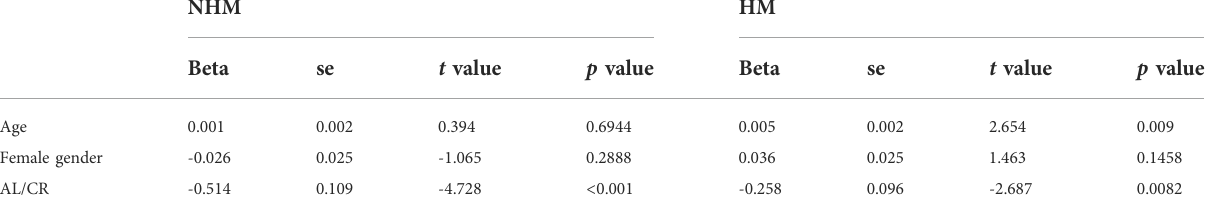
TABLE 2 Modeling of the potential association of SSI with AL/CR adjusted for age and